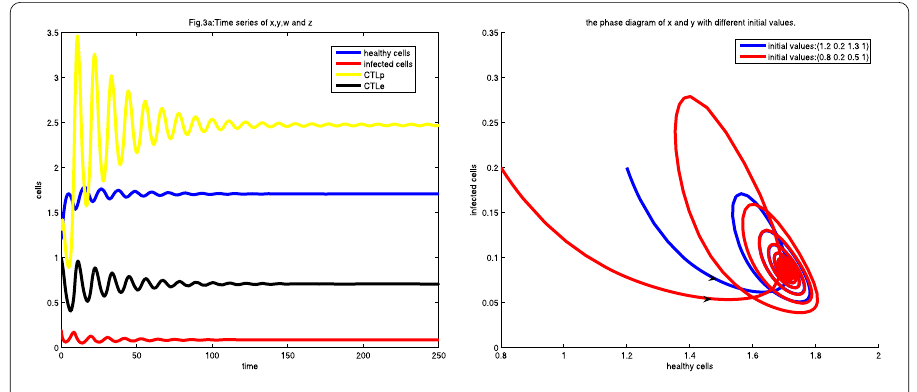
Figure 3 Figure 3( a ) is the diagram of time series of x , y , w , and z at a = 1, and the initial value is (1.2,0.2,1.3,1), whereas Fig. 3( b ) is the phase diagram of x and y with different initial